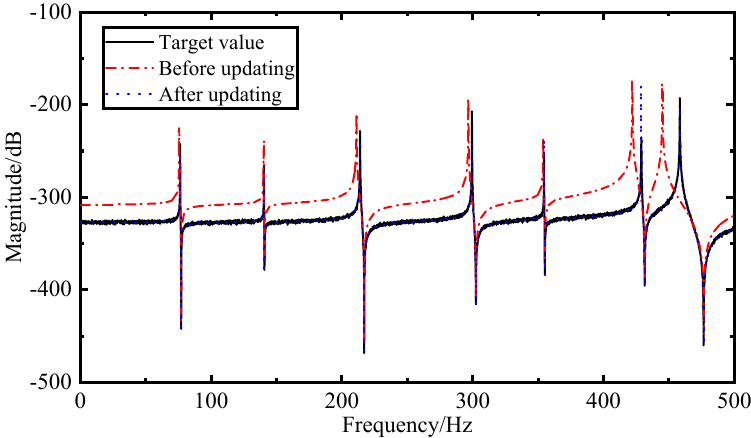
Figure 6. Comparison of FRFs data measured at Node 4 under 5% random white noise.